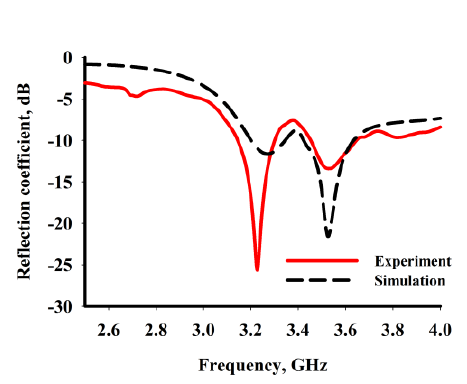
Figure 6: Reflection coefficient of the antenna